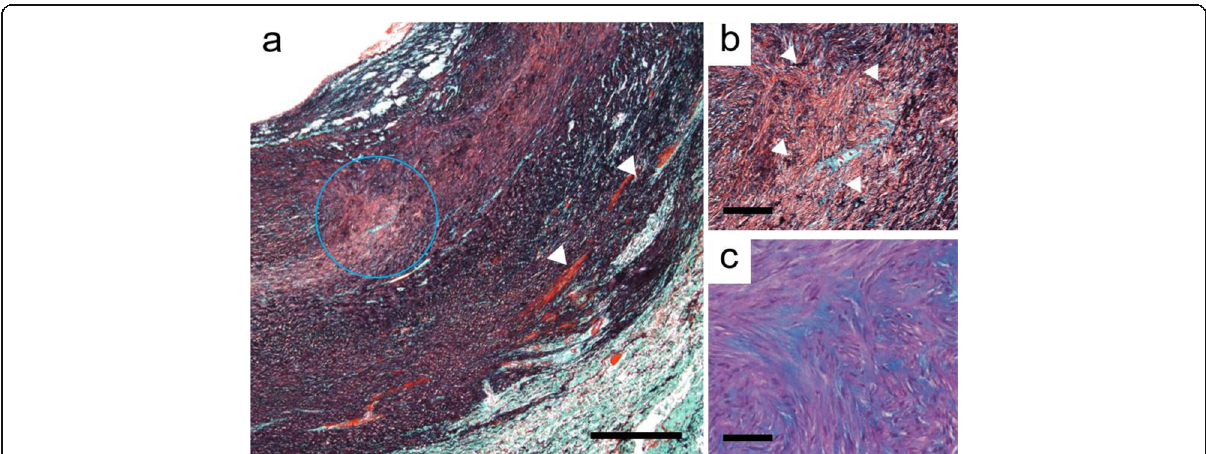
Fig. 3 Pathological examination of the resected KD. a Low-magnification image showing severe disruption and fragmentation of elastic fibers (white arrowhead) associated with a disarray of smooth muscle cells. b High-magnification image of circled area in a showing the same findings. c High-magnification image of circled area in a showing cystic medial necrosis with mucoid extracellular matrix deposition. a , b Elastica-Masson- Goldner stain. c Alcian blue-Periodic acid-Schiff stain. a Bar = 500 μ m. b , c Bar = 100 μ